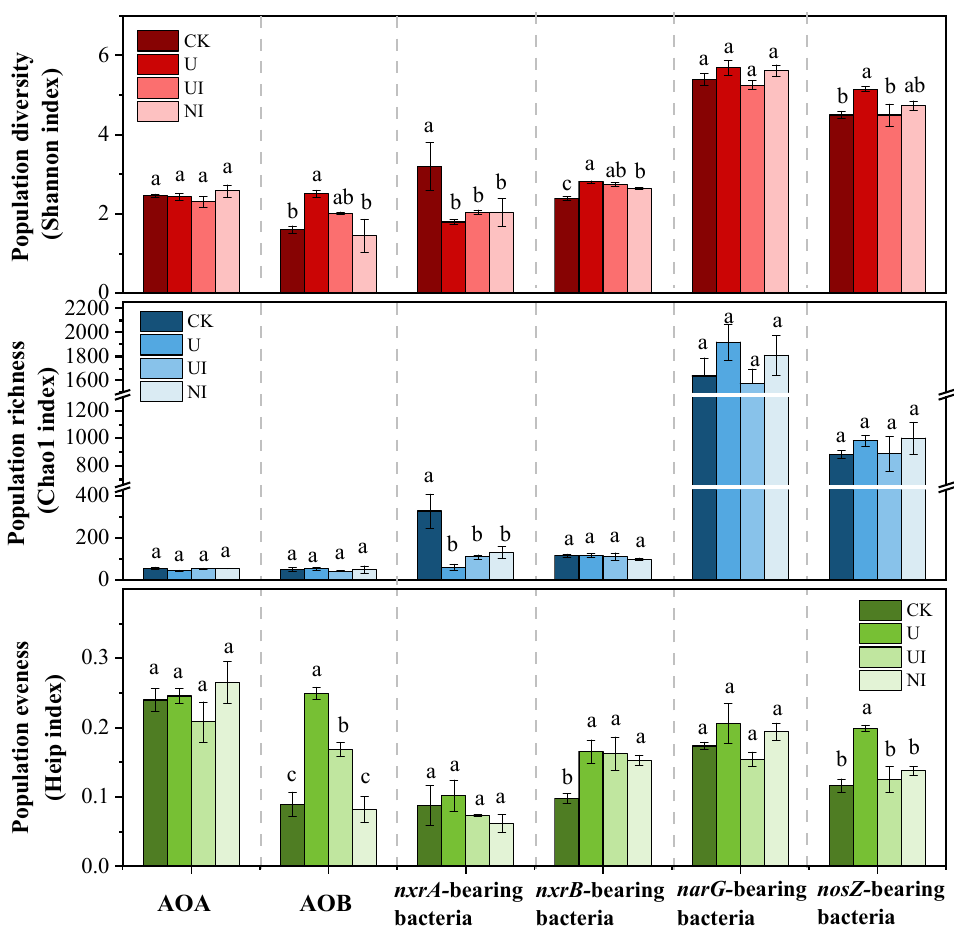
Figure 2. Diversity, richness, and evenness of AOA, AOB, nxrA -bearing, nxrB -bearing, narG -bearing, and nosZ -bearing bacterial population at the OTU level. CK: no nitrogen fertilizer application; U: urea; UI: urea with NBPT; and NI: urea with DMPP. Error bars represent standard errors of three replicates. Different letters above the bars indicate a significant difference at p < 0.05.